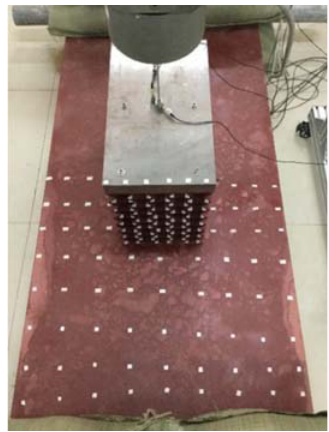
Figure 18: Layout of measuring points for modal test.